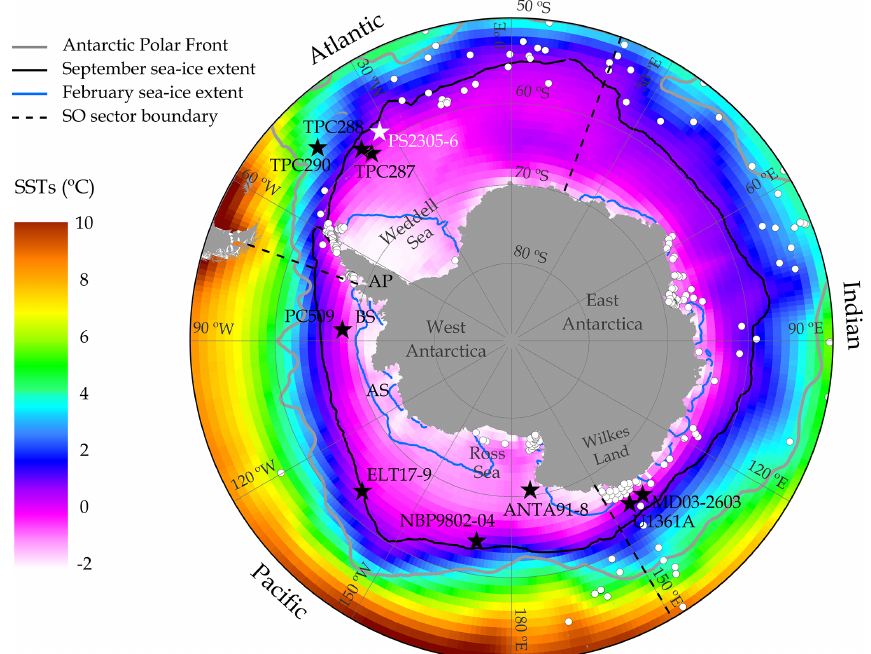
Figure 1. Map of core locations (black stars – this study, white star – Bianchi and Gersonde, 2002) with the modern (1981–2010) mean annual SSTs (COBE-SST2 dataset provided by the NOAA PSL, Boulder, Colorado, USA, https://psl.noaa.gov/, last access: 29 April 2020) and modern (1981–2010) median September and February sea-ice extents (data from Fetterer et al., 2017). White dots mark the locations of surface sediment samples (located south of 50 ◦ S) used as a modern reference dataset for the modern analogue technique transfer function. The black solid line is the September sea-ice extent (15% cover), and the blue solid line is the February sea-ice extent (15% cover). The grey solid line is the position of the modern Antarctic Polar Front (Trathan et al., 2000). The black dashed lines mark the boundaries between the three SO sectors (Atlantic, Indian and Pacific). AP – Antarctic Peninsula, BS – Bellingshausen Sea, AS – Amundsen Sea. Table 1. Details of the location and recovery information for the nine marine sediment cores analysed in this study. Cores are ordered by sector (Atlantic – East Indian – Pacific) and then latitude. Core Latitude ( ◦ ), Water Cruise, year Ship Core length longitude ( ◦